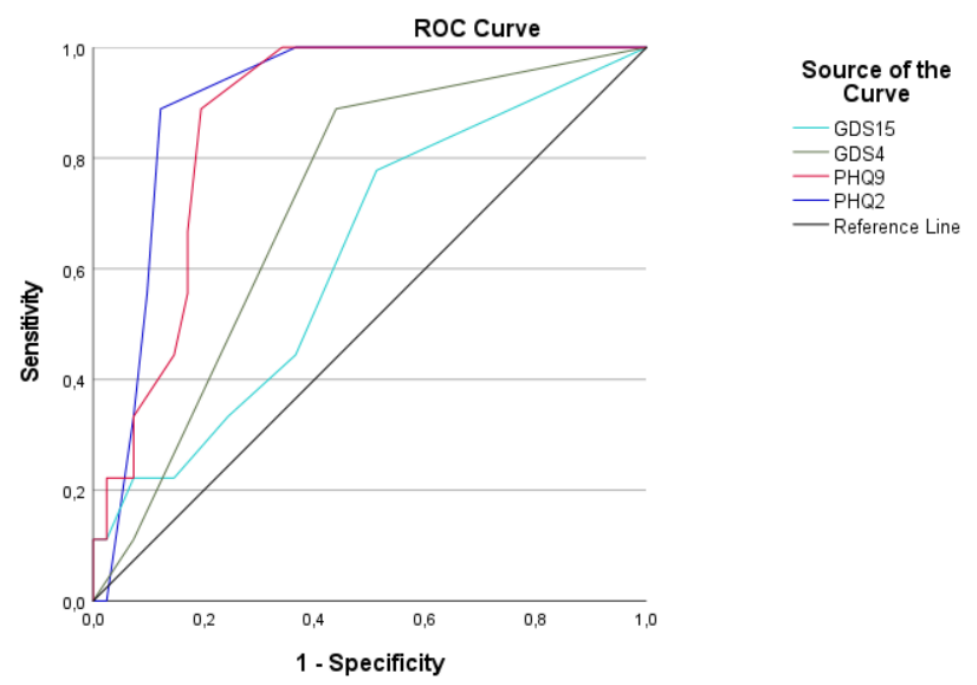
Figure 1. ROC curves of the four depression screening tools according to the gold standard SCID-5-S depression module A. Abbreviations: ROC curve: receiver operating characteristic curve; GDS-15: 15-item version of the Geriatric Depression Scale; GDS-4: 4-item version of the Geriatric Depression Scale; PHQ-9: 9-item version of the Patient Health Questionnaire; PHQ-2: 2-item version of the Patient Health Questionnaire.